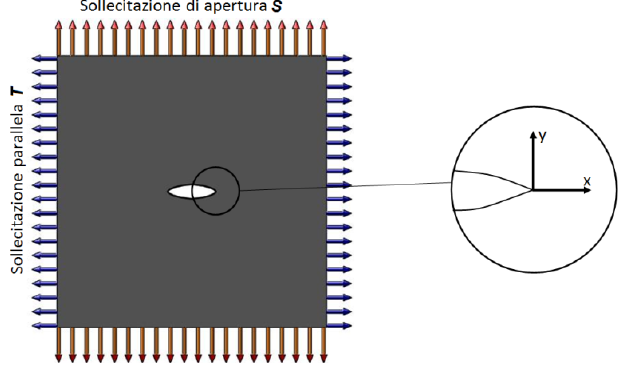
Figura 1: Geometria e disposizione dei cairchi utilizzati per il modello agli elementi finiti.